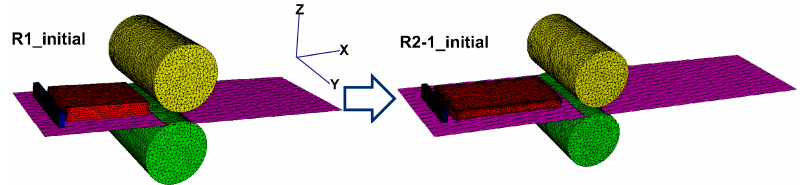
Figure 3. The geometry models and grid structures of the R1 and R2-1 passes.